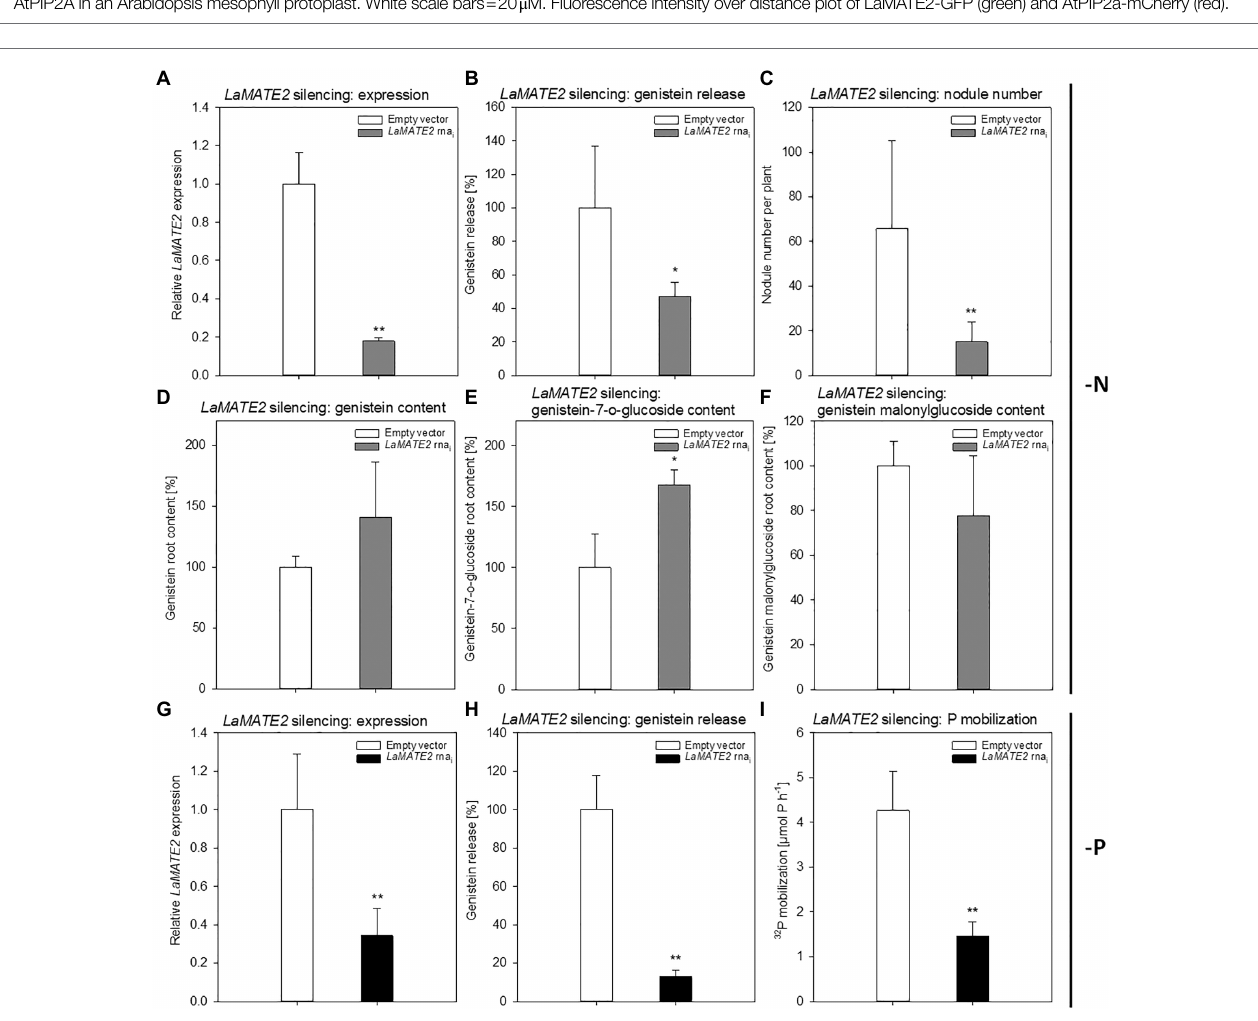
FIGURE 4 | Subcellular localization of LaMATE2. Co-localization of LaMATE2 fused with green fluorescent protein (GFP) and mCherry-labeled plasma membrane marker AtPIP2A in an Arabidopsis mesophyll protoplast. White scale bars = 20 μ M. Fluorescence intensity over distance plot of LaMATE2-GFP (green) and AtPIP2a-mCherry (red).